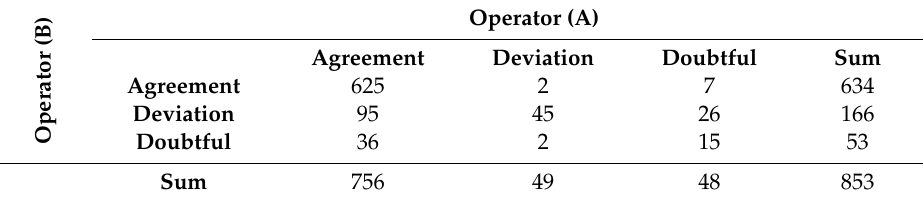
Table 2. The distributions of operators’ rates.